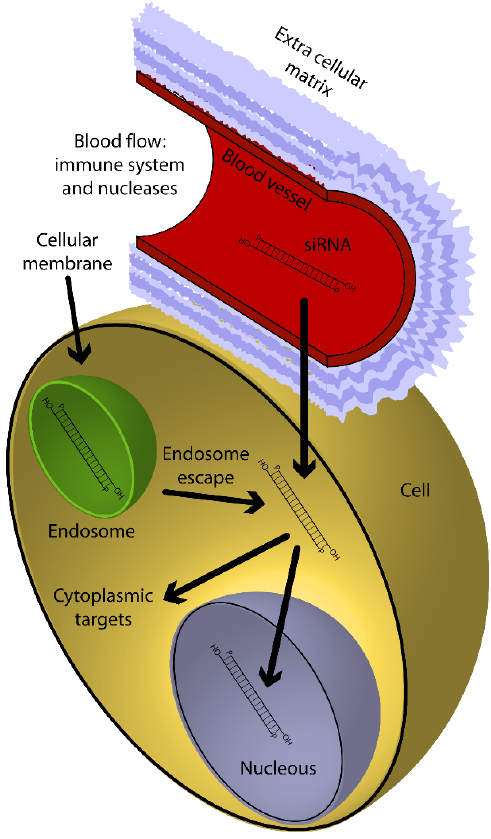
Figure 6. Biological obstacles in NABDs